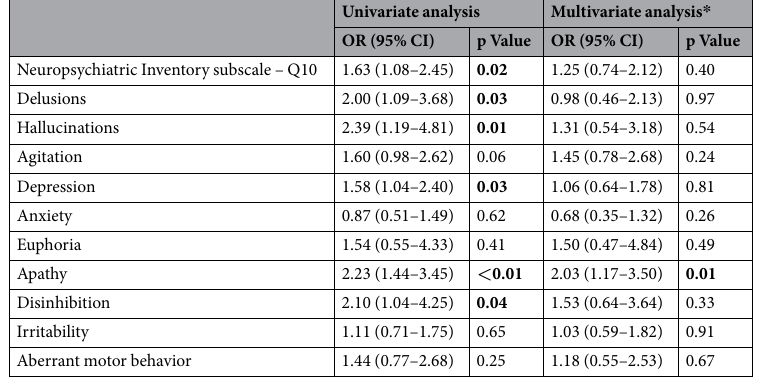
Table 3. Uni- and multivariate logistic regression assessing an association between neuropsychiatric symptoms and delirium. Upper quartile of each score was compared to other quartiles. * Adjusted for age, diabetes, atrial fibrillation, NIHSS score, right hemisphere lesion, pre-stroke cognitive decline, pre-stroke disability, pneumonia and urinary tract